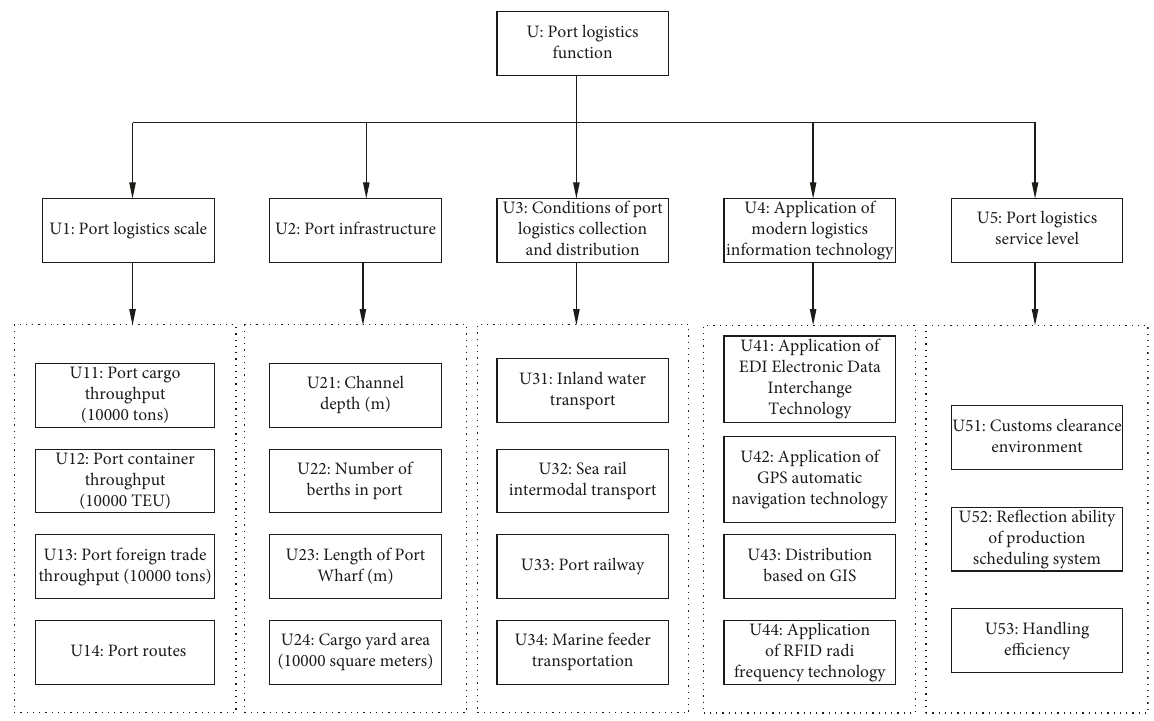
Figure 2: Port logistics function evaluation index